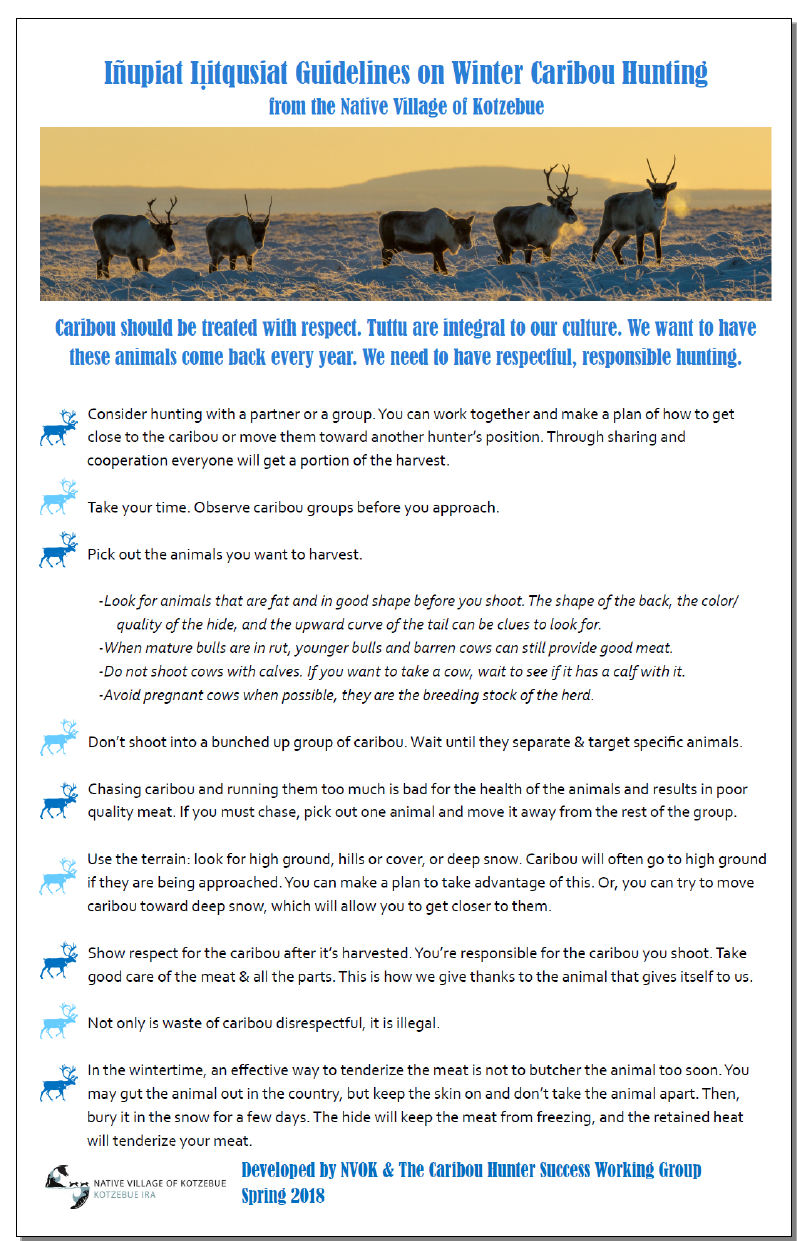
Figure 2. “Iñupiat I ḷ itqusiat Guidelines on Winter Caribou Hunting ” flyer published by Native Figure 2. “Iñupiat Ilitqusiat Guidelines on Winter Caribou Hunting” flyer published by Native Village Village of Kotzebue in 2018. of Kotzebue in